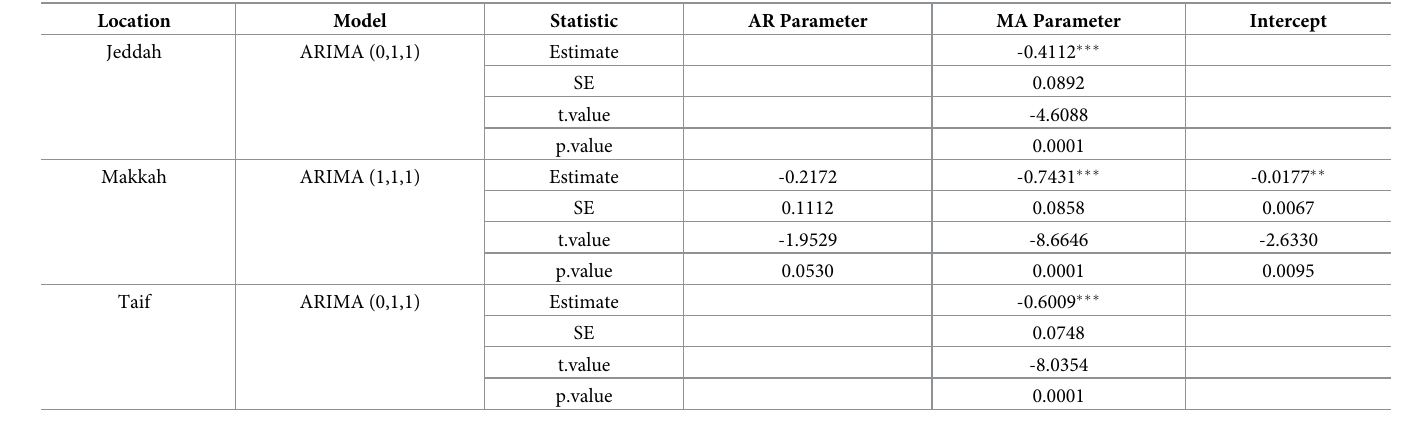
Table 2. The results of ARIMA model.